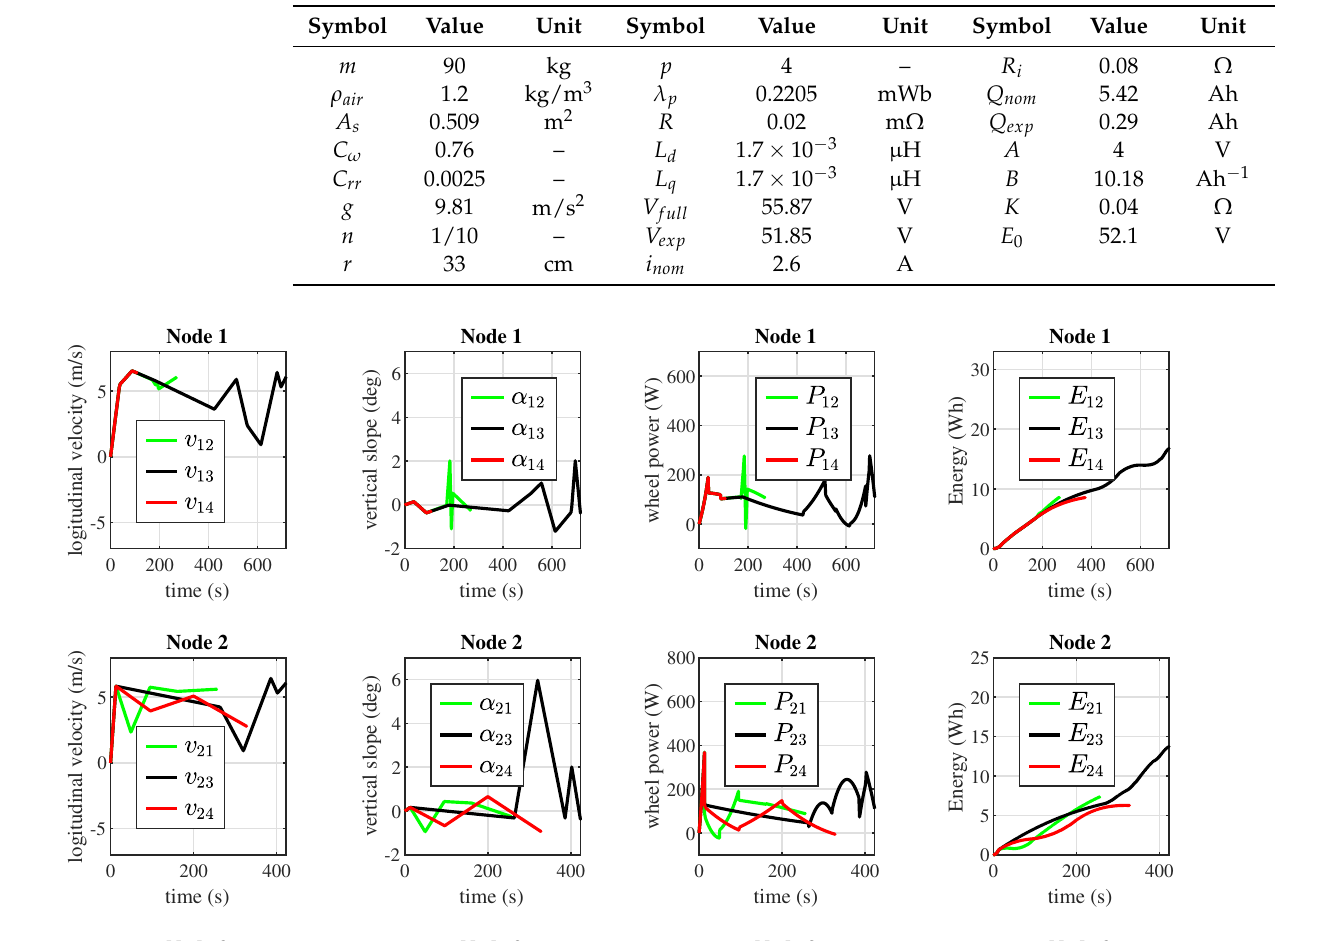
Table 1. Parameters used in e-bike simulations.